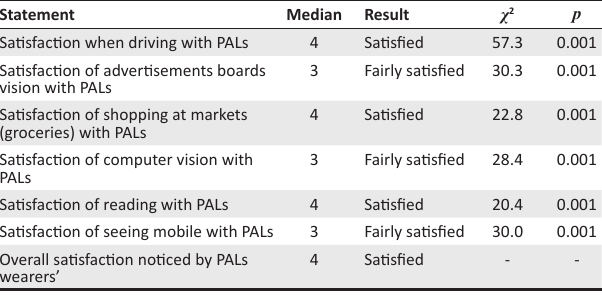
TABLE 2: Vision satisfaction analysis for respondents ( n = 136 progressive addition lenses wearers).